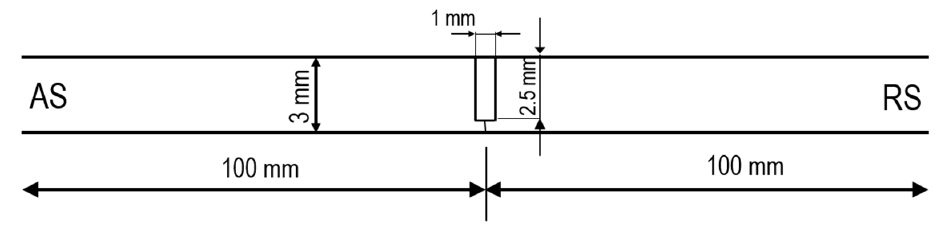
Figure 3. Example schematics of groove formation for usage in reinforcing